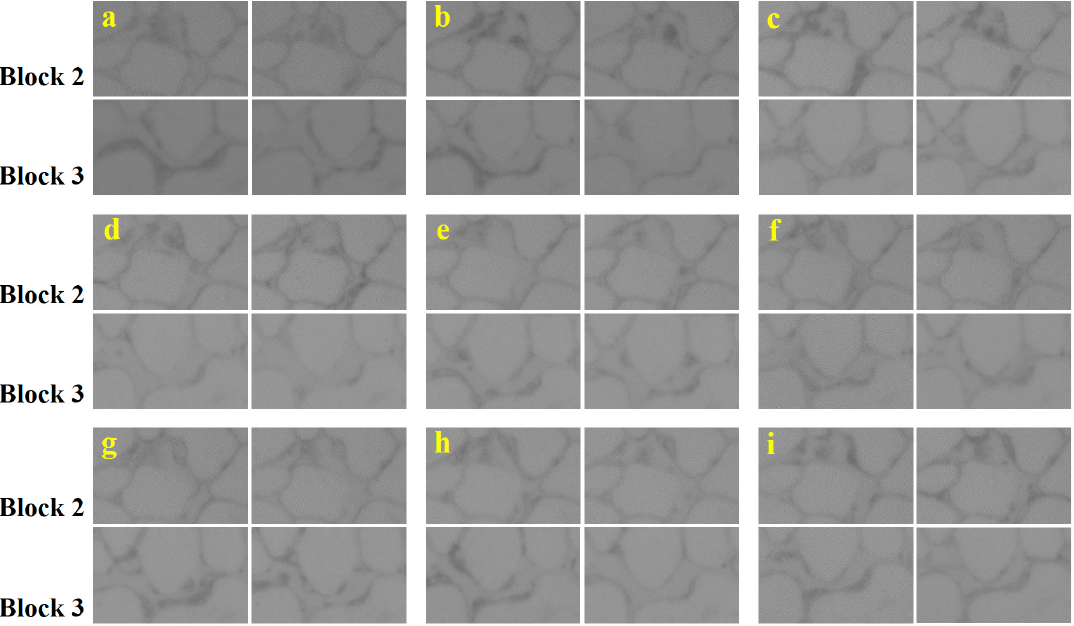
Figure 8. The oil/water distribution in Block 2 and 3 at 100th and 200th images (( a )—0 Hz, ( b )—1 Hz and 0.005 mL/min, ( c )—1 Hz and 0.01 mL/min, ( d )—2 Hz and 0.005 mL/min, ( e )—2 Hz and 0.01 mL/min, ( f )—3 Hz and 0.005 mL/min, ( g )—3 Hz and 0.01 mL/min, ( h )—2 Hz and 0.005 mL/min, ( i )—2 Hz and 0.01 mL/min).